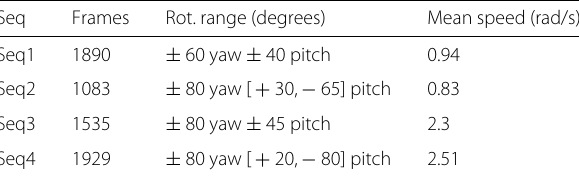
Table 1 Description of our own head pose sequences